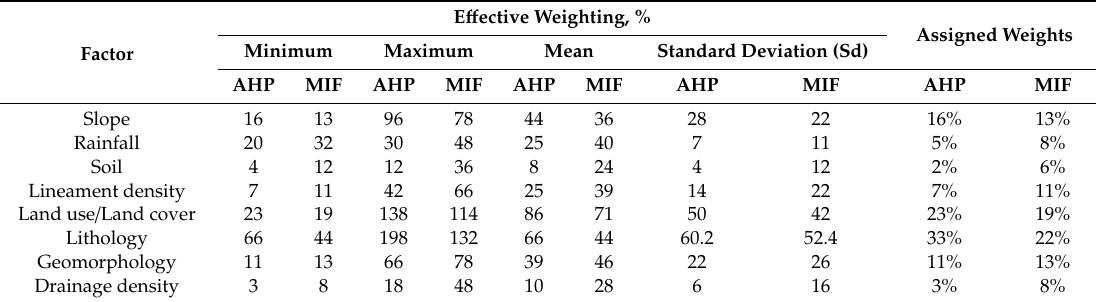
Table 10. Statistics of the single parameter sensitivity